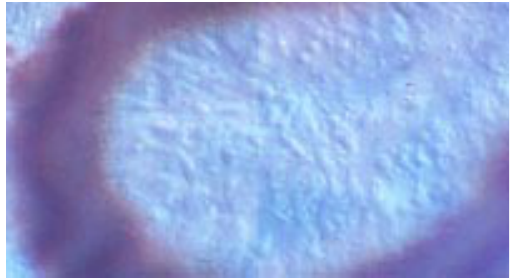
Fig. 4. Phaeoacremonium chlamydosporum – pycnidia produced on surface of naturally infected, moist incu- bated wood (VPRI 22081b).